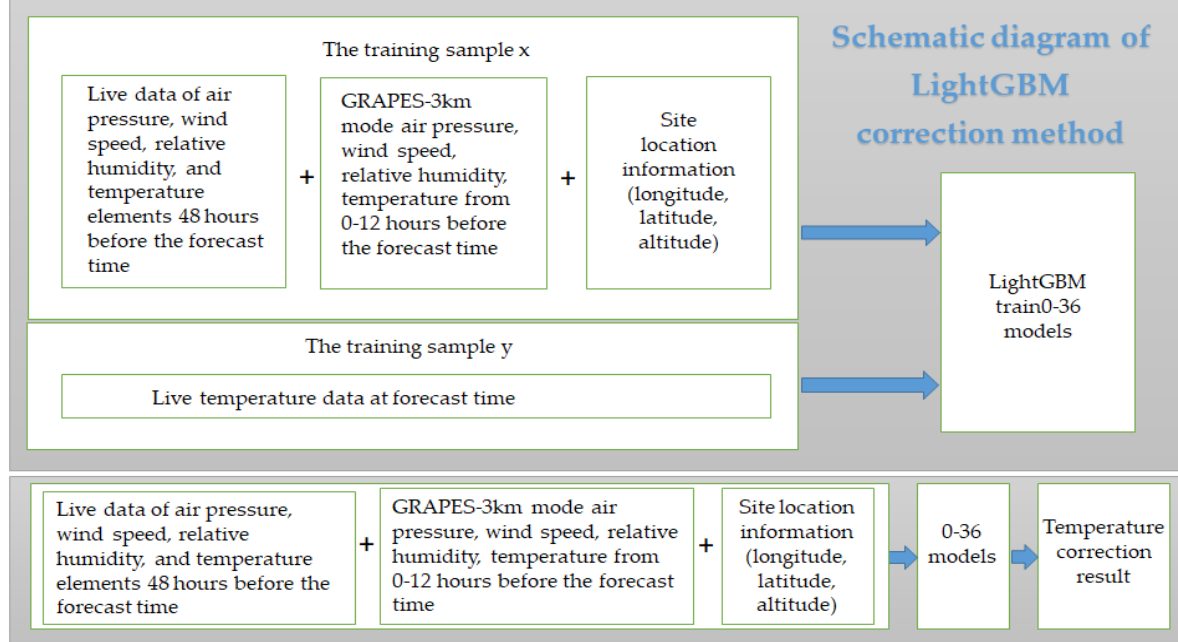
Figure 3. Schematic diagram of LightGBM correction method.